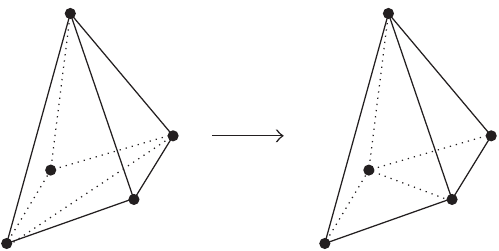
Figure 5: Three-dimensional face